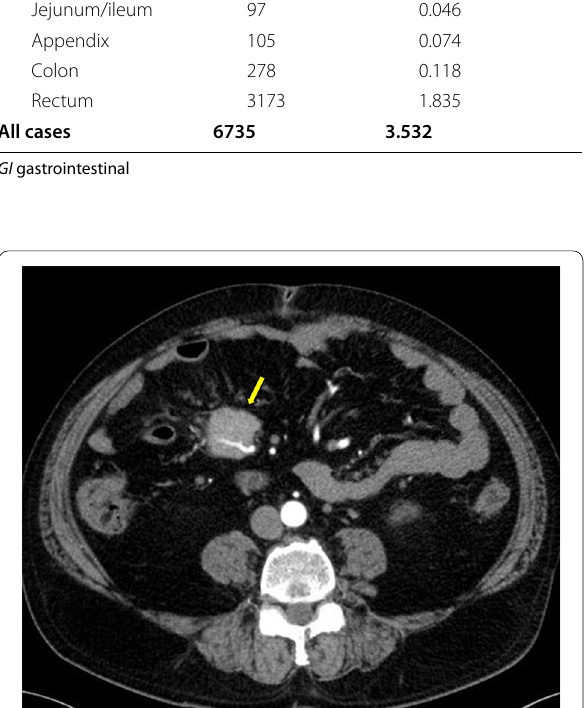
Fig. 3 The tumor is located in the mesentery of the ileum and retracted into the mesentery